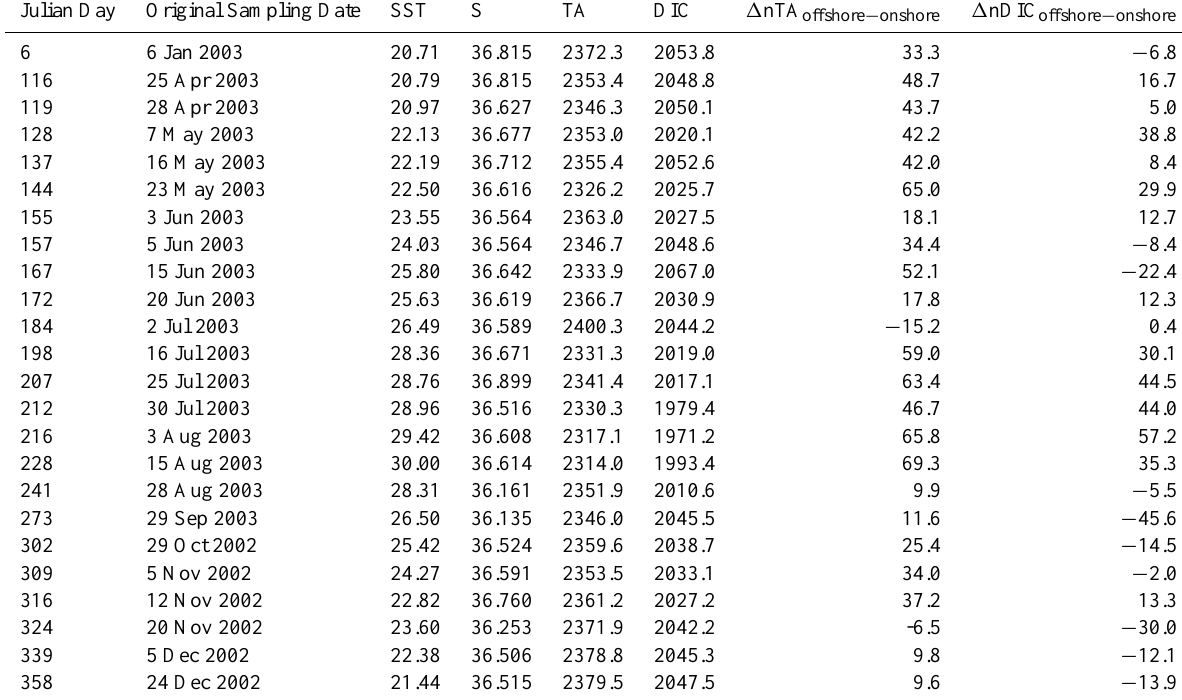
Table 3. Hog Reef TA and DIC data compiled into a composite year. Julian day of sampling is shown along with original sampling data, sea surface temperature (SST), salinity (S), DIC and TA data (both µmoleskg − 1 ). These data are used in Sect. 4.4 to calculate rates of NEP reef and NEC reef using 1 nTA offshore − onshore and 1 nDIC offshore − onshore values. 1 nTA offshore − onshore and 1 nDIC offshore − onshore are calculated from nTA and nDIC (adjusted to a salinity of 36.6) using contemporaneous Hog Reef (onshore) and BATS data